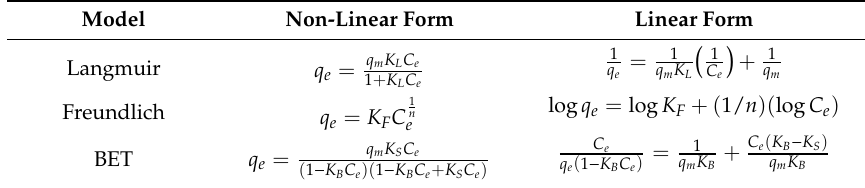
Table 6. Lists of adsorption isotherms models under